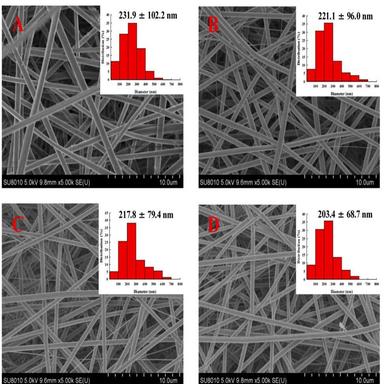
The SEM images and diameter distributions of the P/E-CA composite nanofiber films: (A) P/E-CA0; (B) P/E-CA2; (C) P/E-CA4; (D) P/E-CA8.